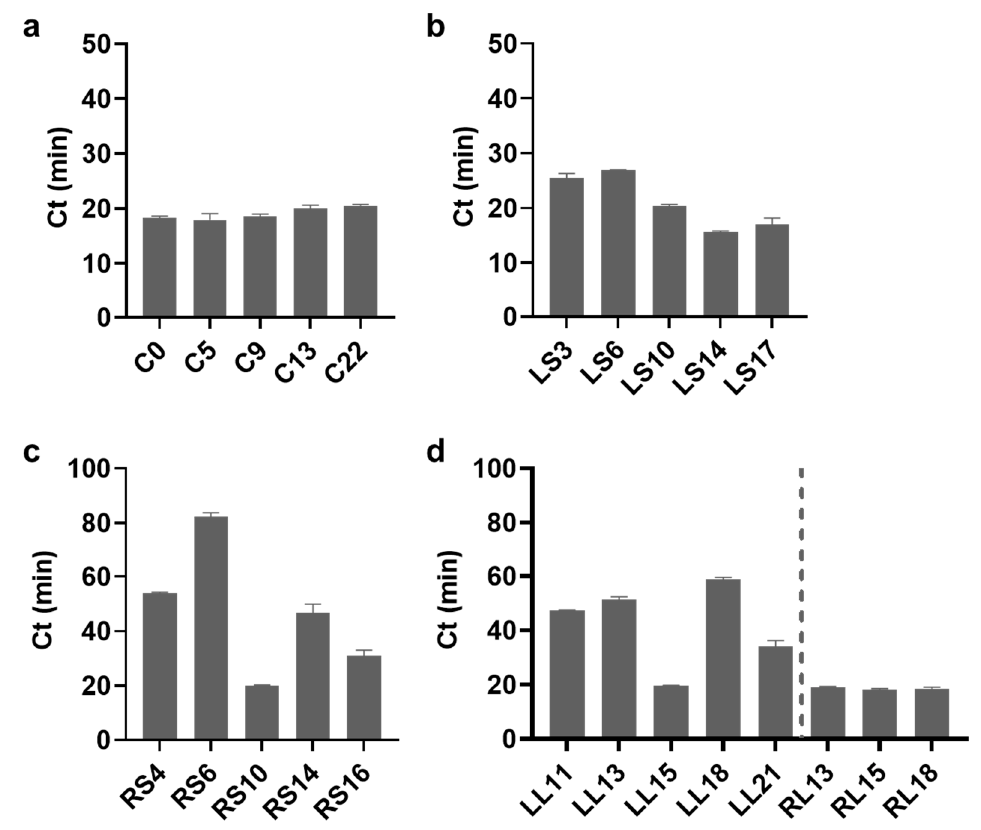
Figure 4. Optimization of the length on each part of the SLP for low-temperature LAMP. Ct values according to the different lengths of the ( a ) center (C), ( b ) left stem (LS), ( c ) right stem (RS), ( d ) left loop (LL), and right loop (RL) of the SLP. The grey dotted line is indicated to facilitate the distinction of LL and RL. The concentration of SLP was 50 pM. All tests were performed with three technical replicates.